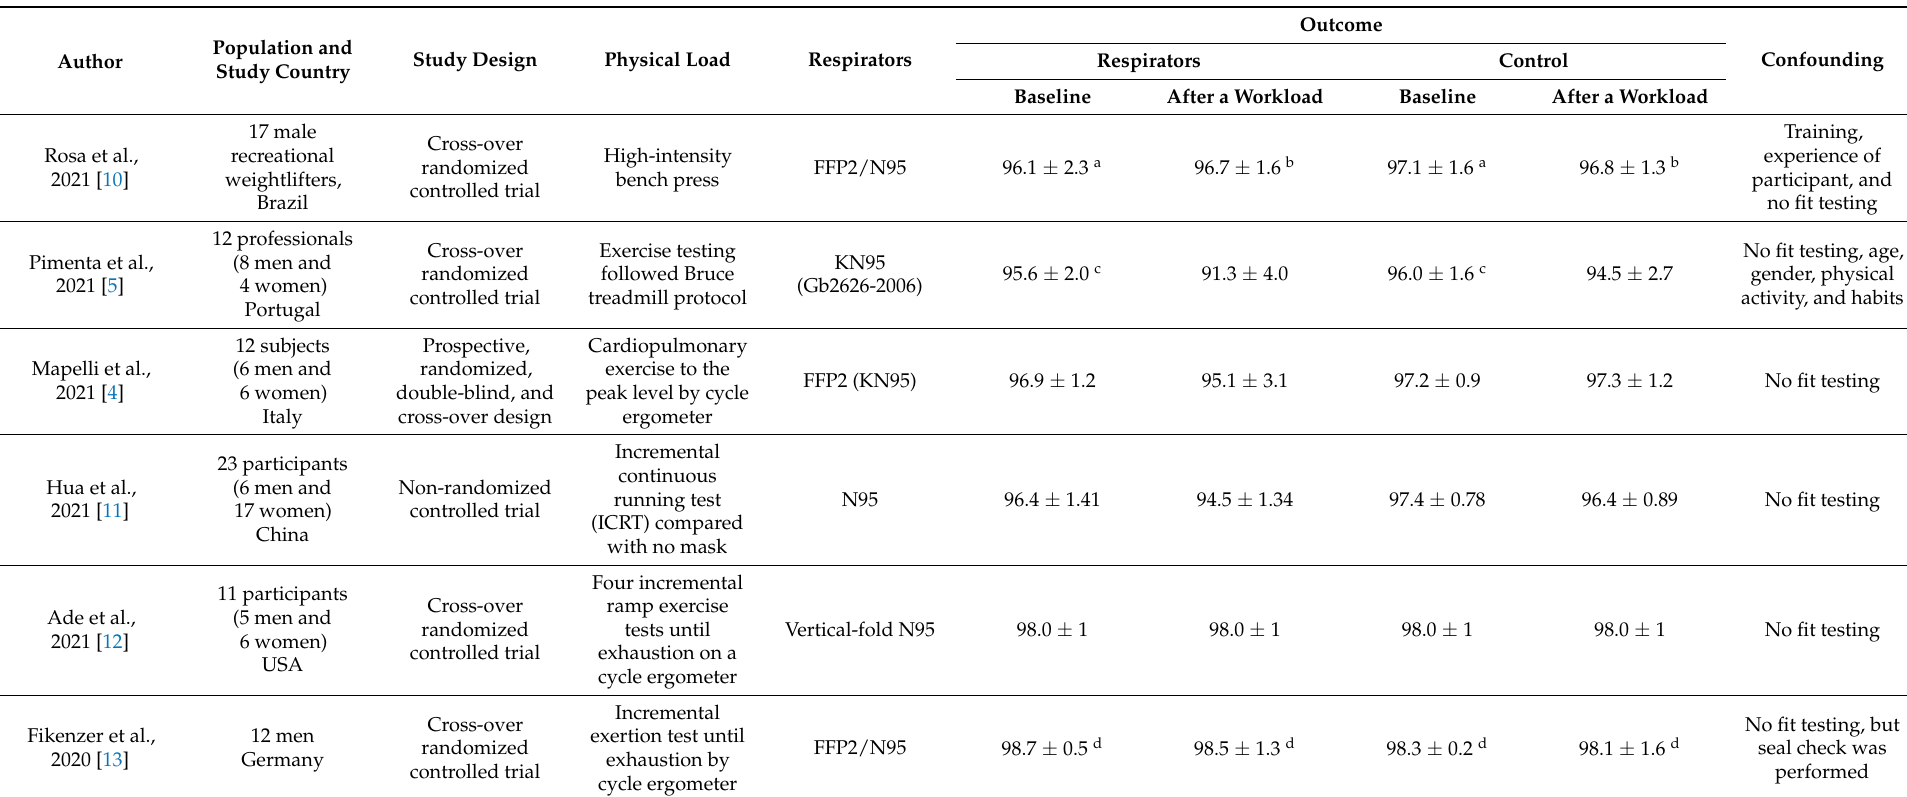
Table 1. Oxygen Saturation in High Physical Workload. a after 1st set of exercises, b after 4th set of exercises, c after 1 min warm-up, and d SpO 2 was calculated from PaO 2